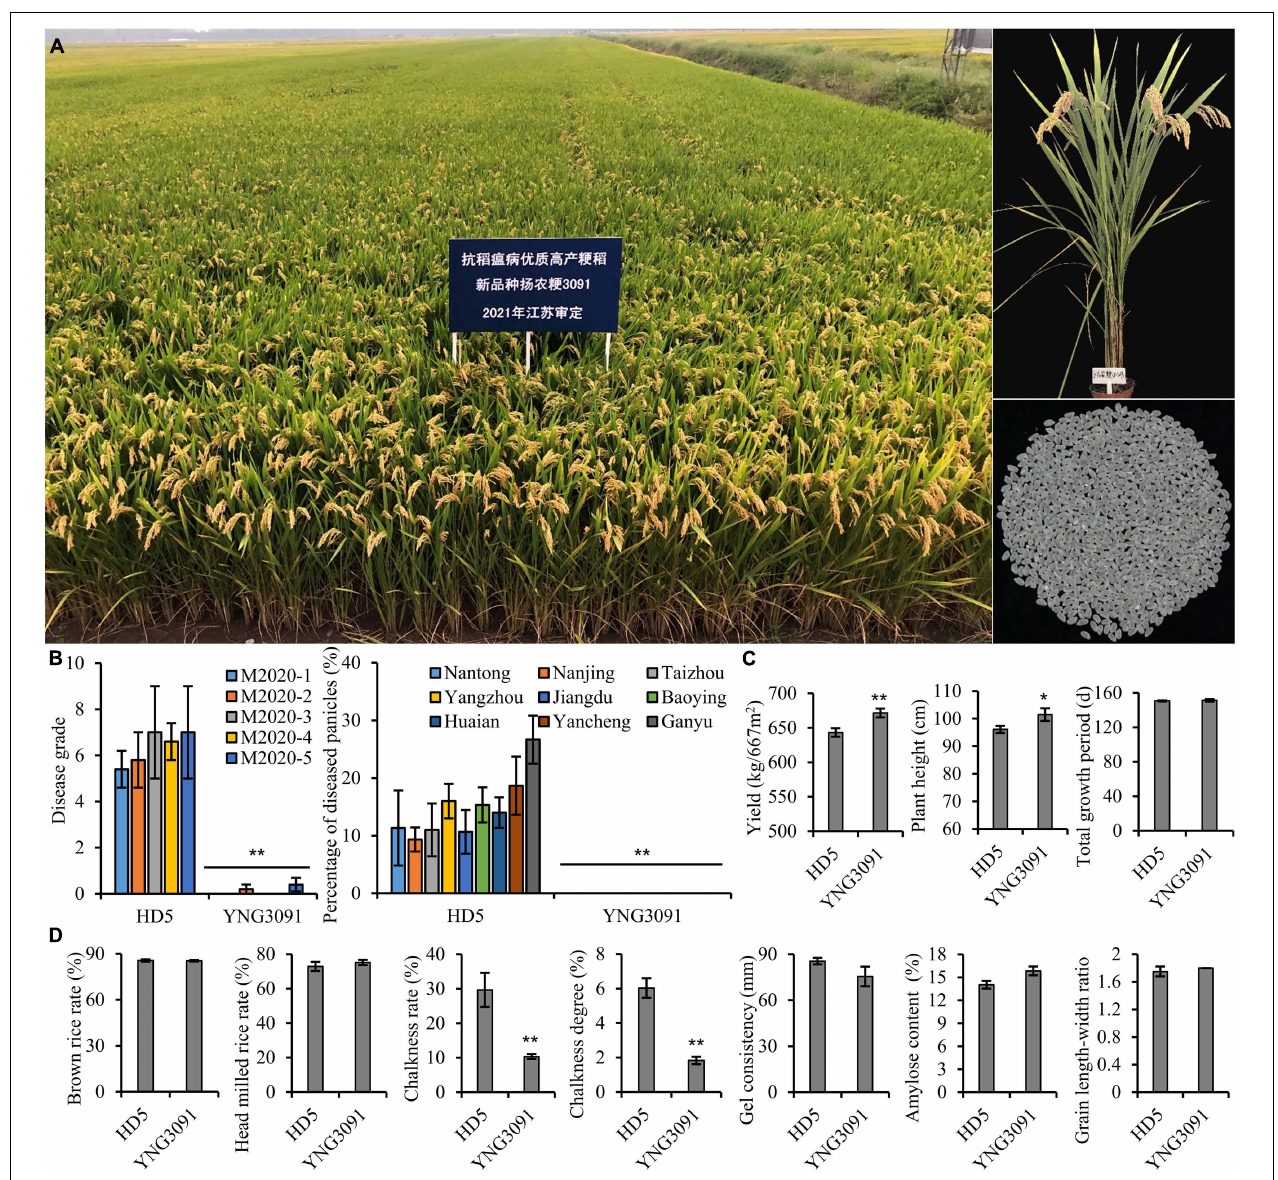
FIGURE 5 | Breeding high blast-resistant rice variety Yangnonggeng 3091 (YNG 3091) with high yield and quality. (A) Field performance and milled rice grains of YNG3091. (B–D) Comparison of blast resistance levels (B) , important agronomic traits (C) , and grain quality traits (D) between YNG3091 and the control cultivar Huaidao 5 (HD5). * P < 0.05, ** P < 0.01 compared with HD5 by Student’s t